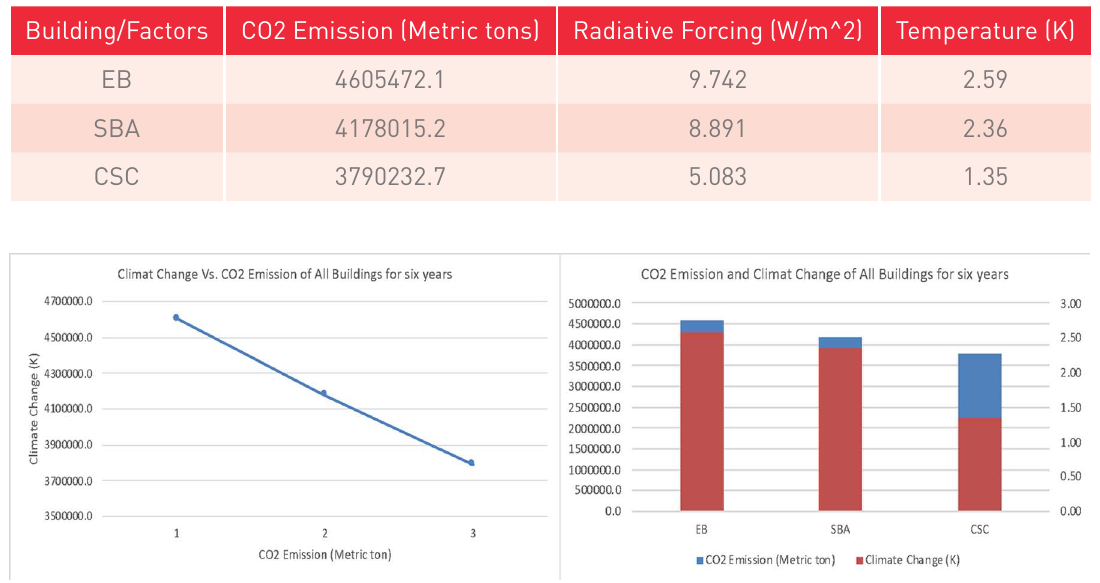
Figure 11. Climate Change Vs. CO2 Emission of all Buildings for Six